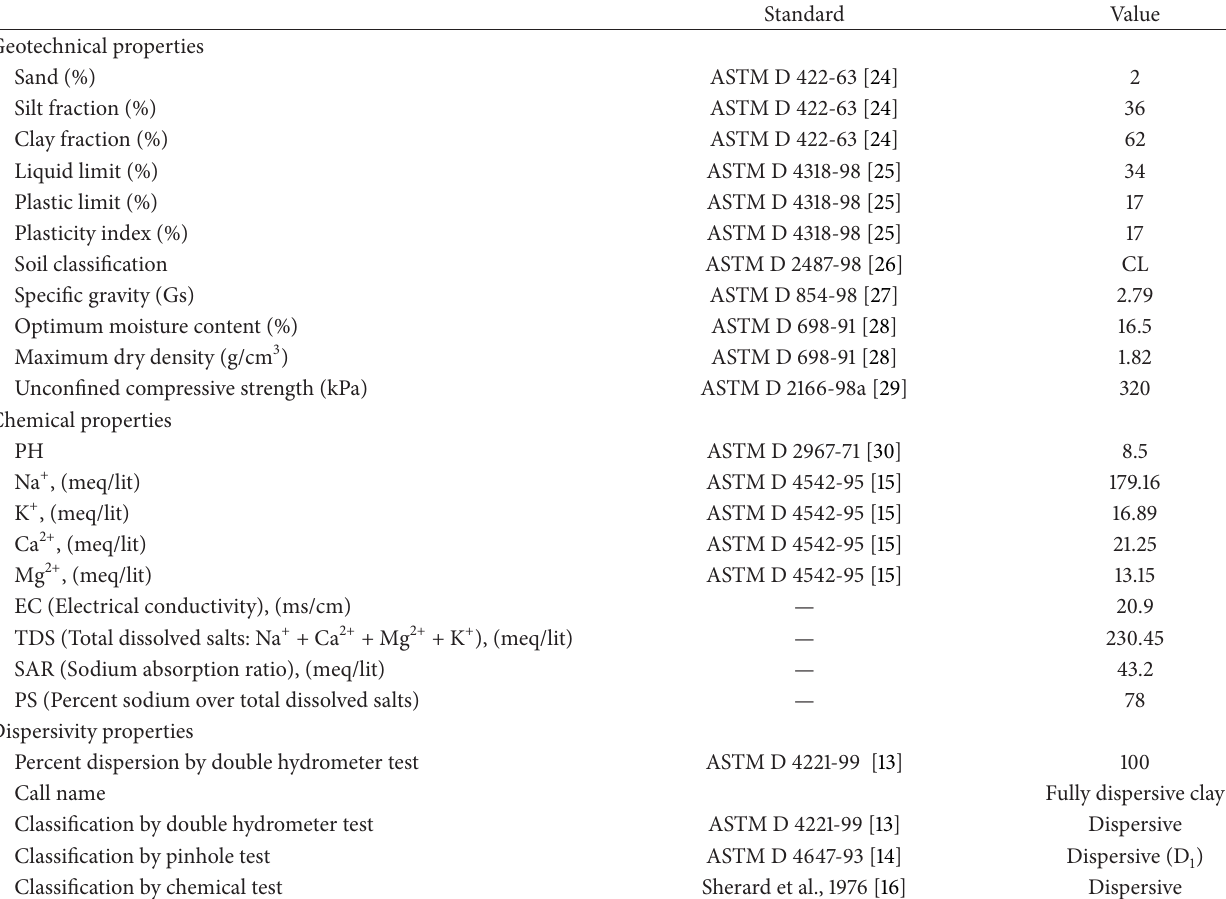
Table 1: Properties of clay from Azerbaijan which has been altered to become fully